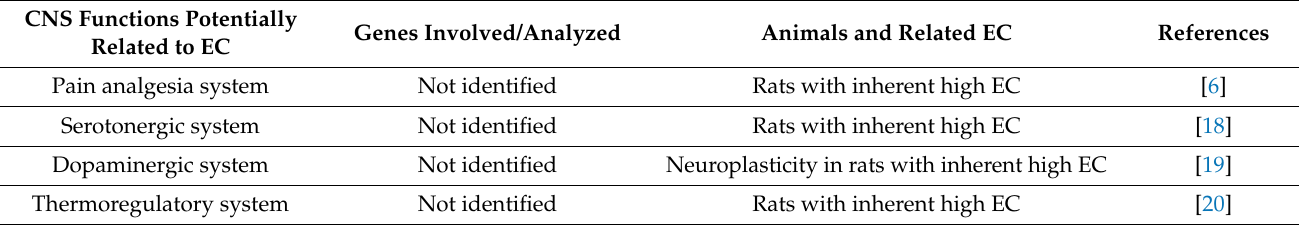
Table 1. Functions of the central nervous system (CNS) potentially related to inherent exercise capacity (EC) in